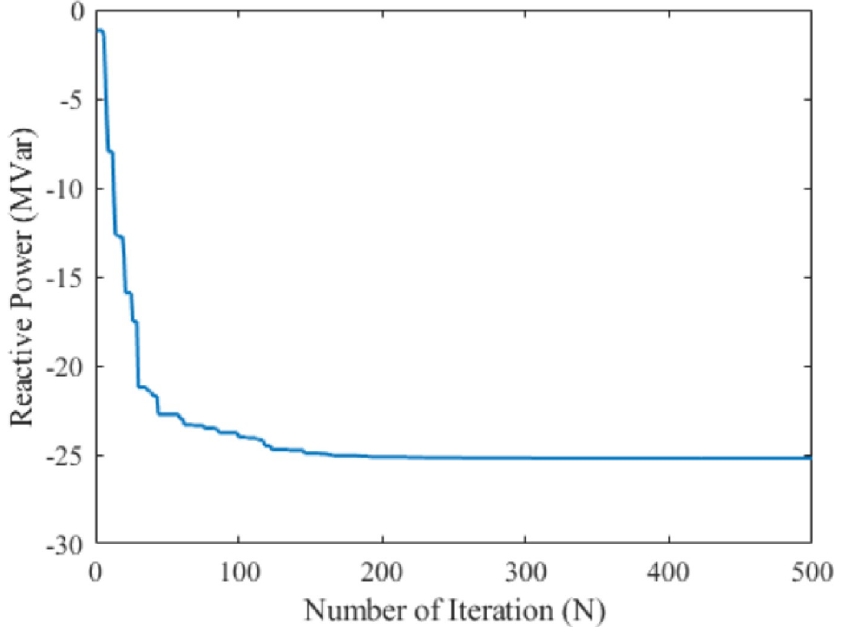
Fig 6. Convergence property of the proposed MPA for case 3.